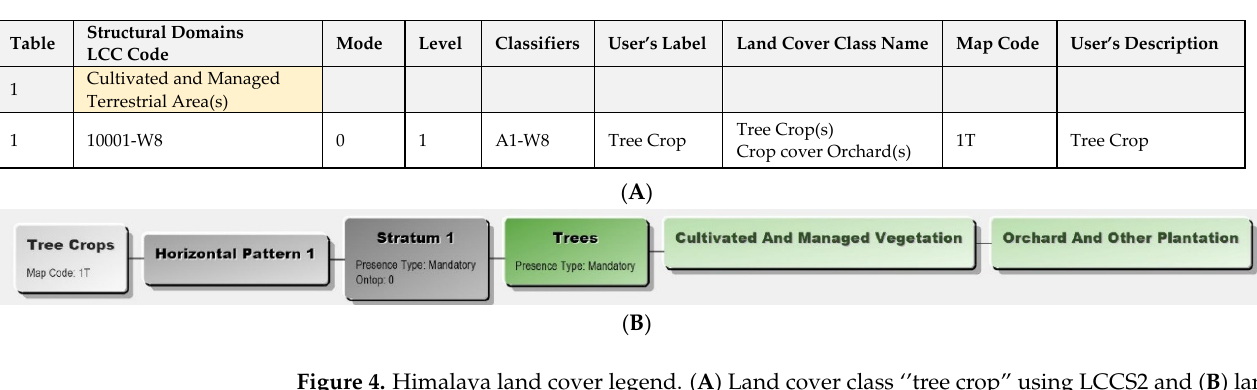
Figure 3. Non-irrigated arable land class in CORINE land cover legend using the LCCS3 tool.